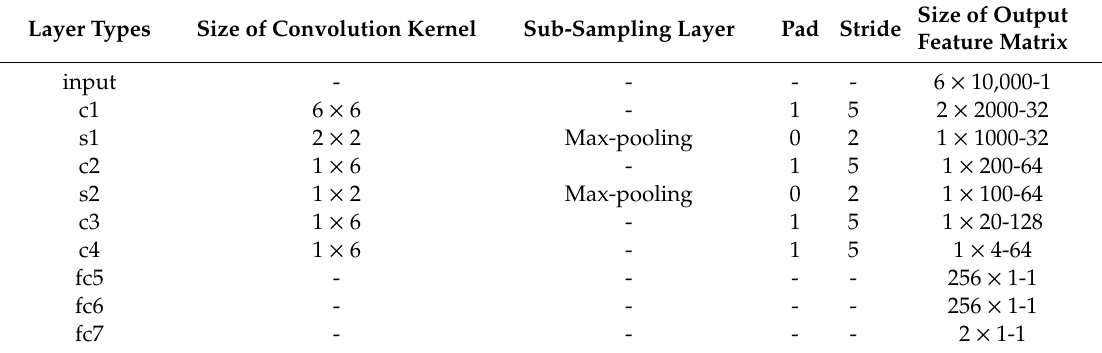
Table 1. Deep neural network (DNN) configuration of each